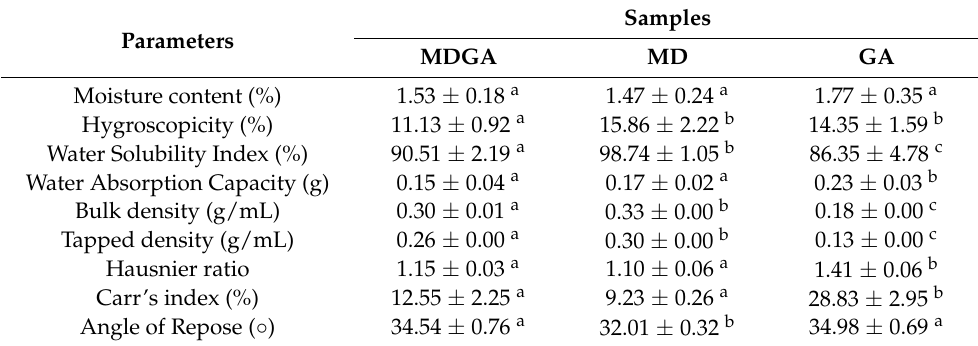
Table 1. Physical properties of MoLP extract microcapsules. Parameters